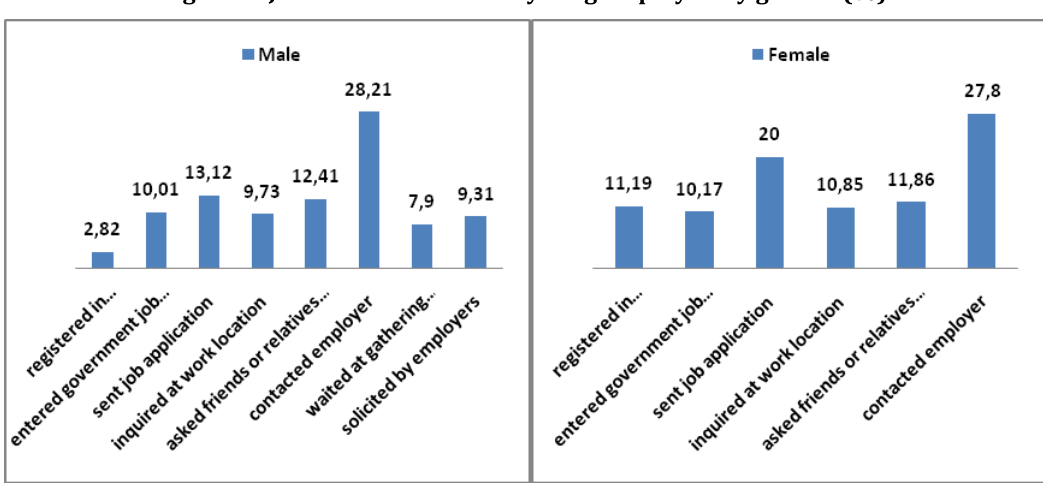
Figure 6: Job search methods of young employed by gender (%)